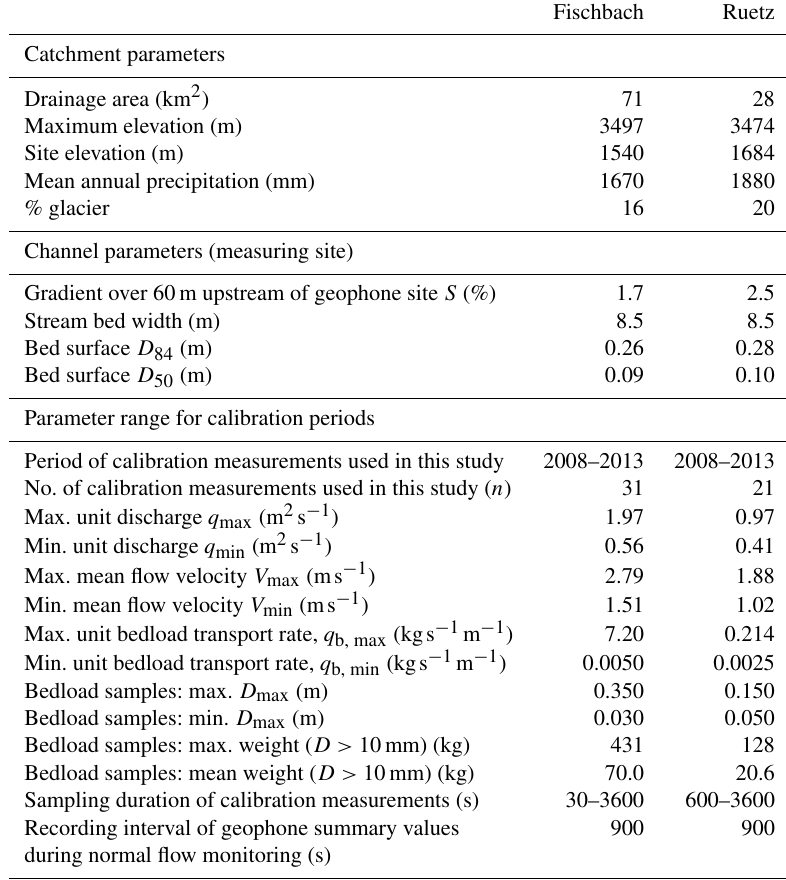
Table 1. Catchment and channel characteristics at the field sites and range of typical parameters for the conditions during the geophone calibration measurements. The q b values refer to bedload with D > 10mm.